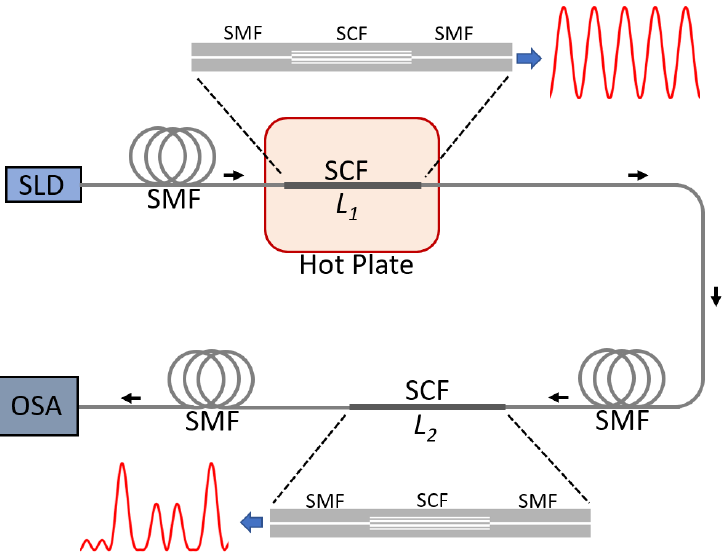
Figure 5. Experimental setup for temperature measurements using the concatenated SMF ‐ SCF ‐ SMF devices. SLD: superluminescent diode, OSA: optical spectrum analyzer, SMF: single ‐ mode fiber, SCF: seven ‐ core fiber. Red curves indicate representative spectra after each SMF ‐ SCF ‐ SMF device. Black arrows indicate the direction of light inside the fiber sensor.